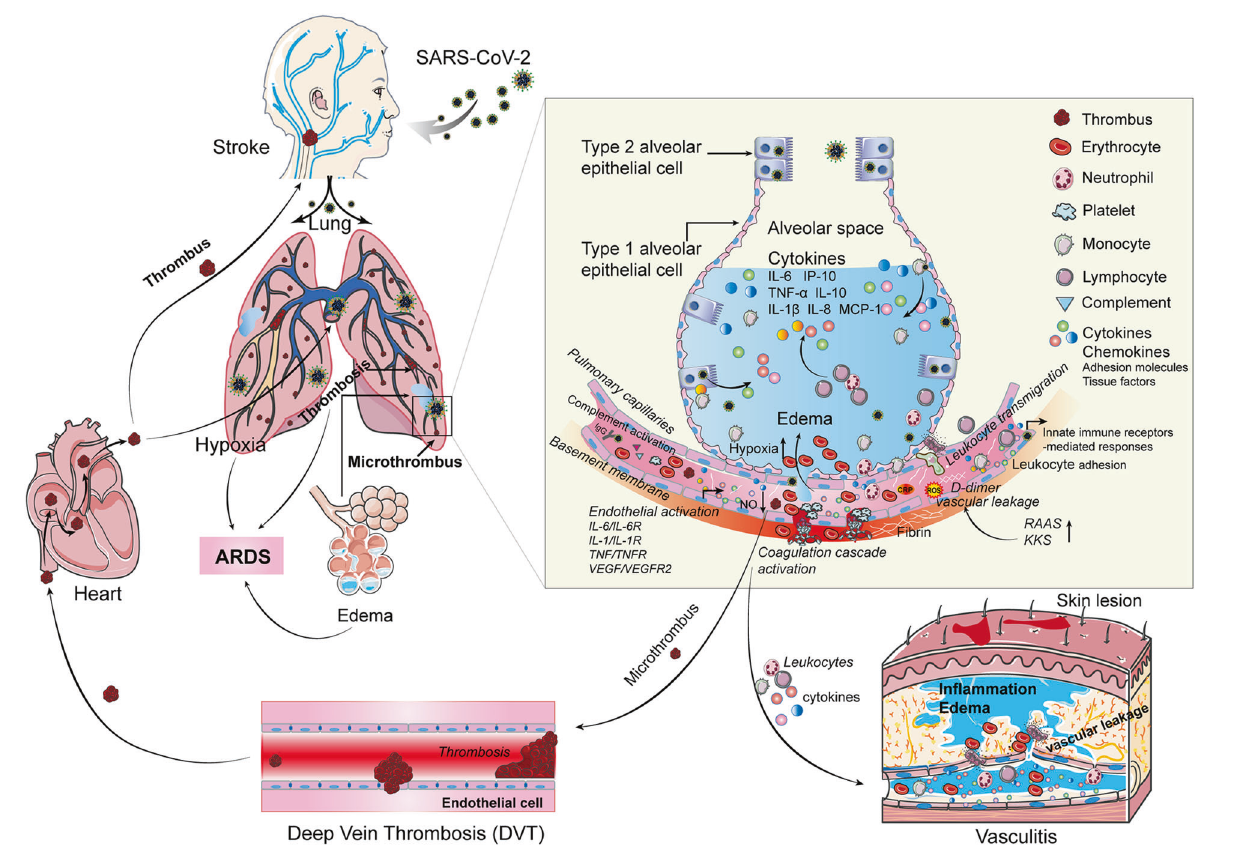
Fig. 2 Overview of endothelial activation and dysfunction in the pathogenesis of COVID-19. In the initial stage of severe COVID-19 patients, SARS-CoV-2 infection causes acute lung injury, and then excessive cytokines are released from immune cells, bronchial epithelial cells, and alveolar cells. SARS-CoV-2 infection and various cytokines are predicted to cause endothelial activation and dysfunction by multiple pathways, leading to vascular in fl ammation and permeability. Then more immune cells enter or migrate into alveoli and enhance lung in fl ammation. With vascular permeability, erythrocytes enter into alveoli, leading to edema. Moreover, with the release of pro-in fl ammatory cytokines and in fl ammatory cells to circulation, vasculitis occurs. The disruption of vascular integrity and EC apoptosis leads to the exposure of the thrombogenic basement membrane and the activation of the clotting cascade. Endothelial cells release relevant cytokines that further augment platelet production. Platelet activation is the primary cause of thrombosis. In fl ammation, edema, and microthrombus work together to cause ARDS. The transfer of microthrombi into the blood circulation increases the risk of the formation of deep vein thrombosis, which may further cause pulmonary embolism and